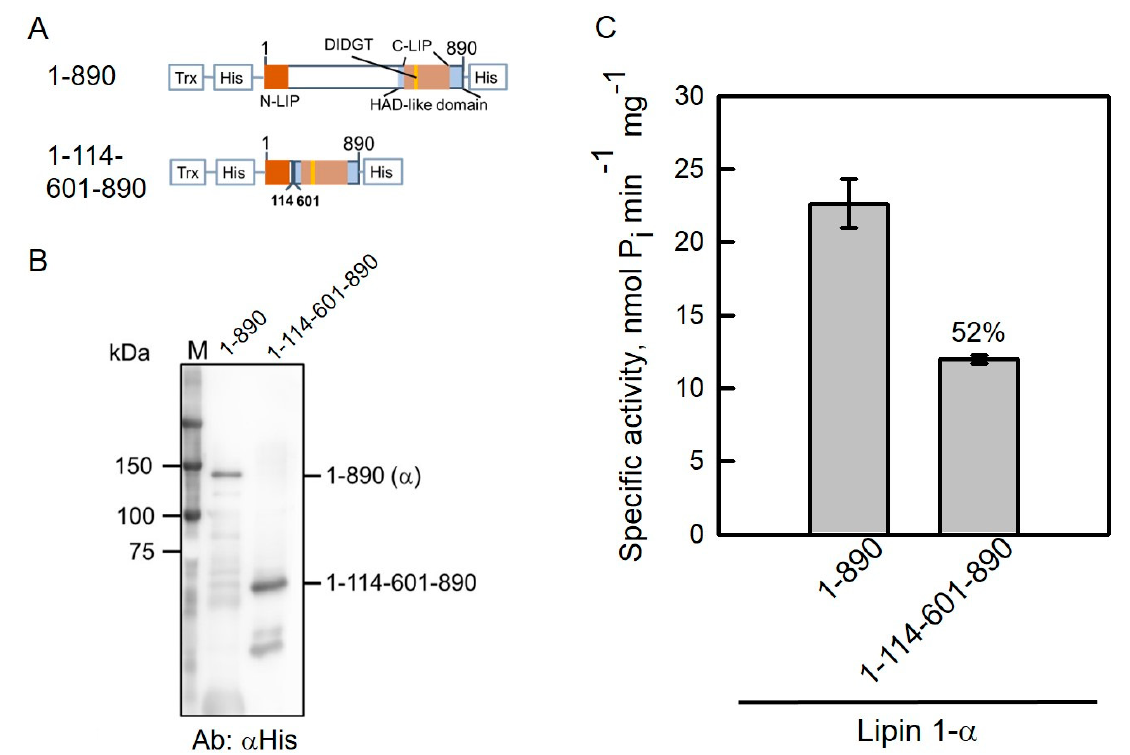
Figure 5. NLIP and HAD-like domains are essential for Lipin 1 catalytic activity. ( A ) The full-length and truncated Lipin 1- α proteins fused with thioredoxin (Trx) and His 6 -tags at both termini. ( B ), Lipin 1- α truncations were expressed in E. coli and purified by Ni-NTA resin. Proteins were subjected to SDS-PAGE followed by Western blotting analysis with the anti-His antibodies. ( C ) PAP activities were measured in Pah1 truncations. The data are the average of triplicate experiments ± S.D. (error bars).